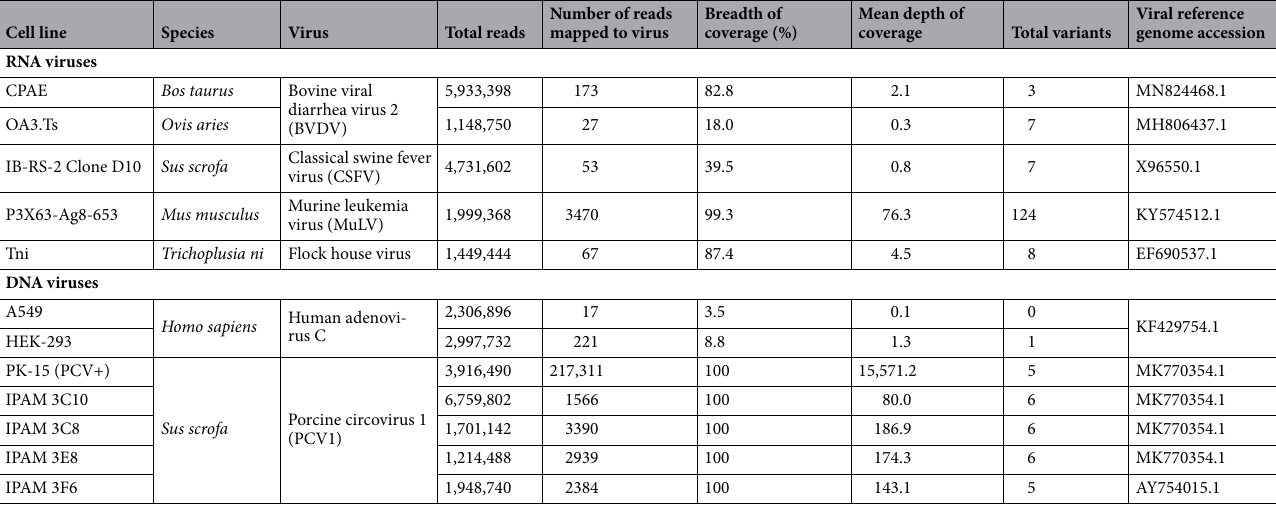
Table 3. List of viral genomes detected in the cell lines. Only retroviruses with > 98% genome coverage were included. Variants were only called if the read depth had a minimum coverage of 3×. Threshold for coverage depth for calling breadth and depth of coverage was set to 3, while the minimum variant frequency =